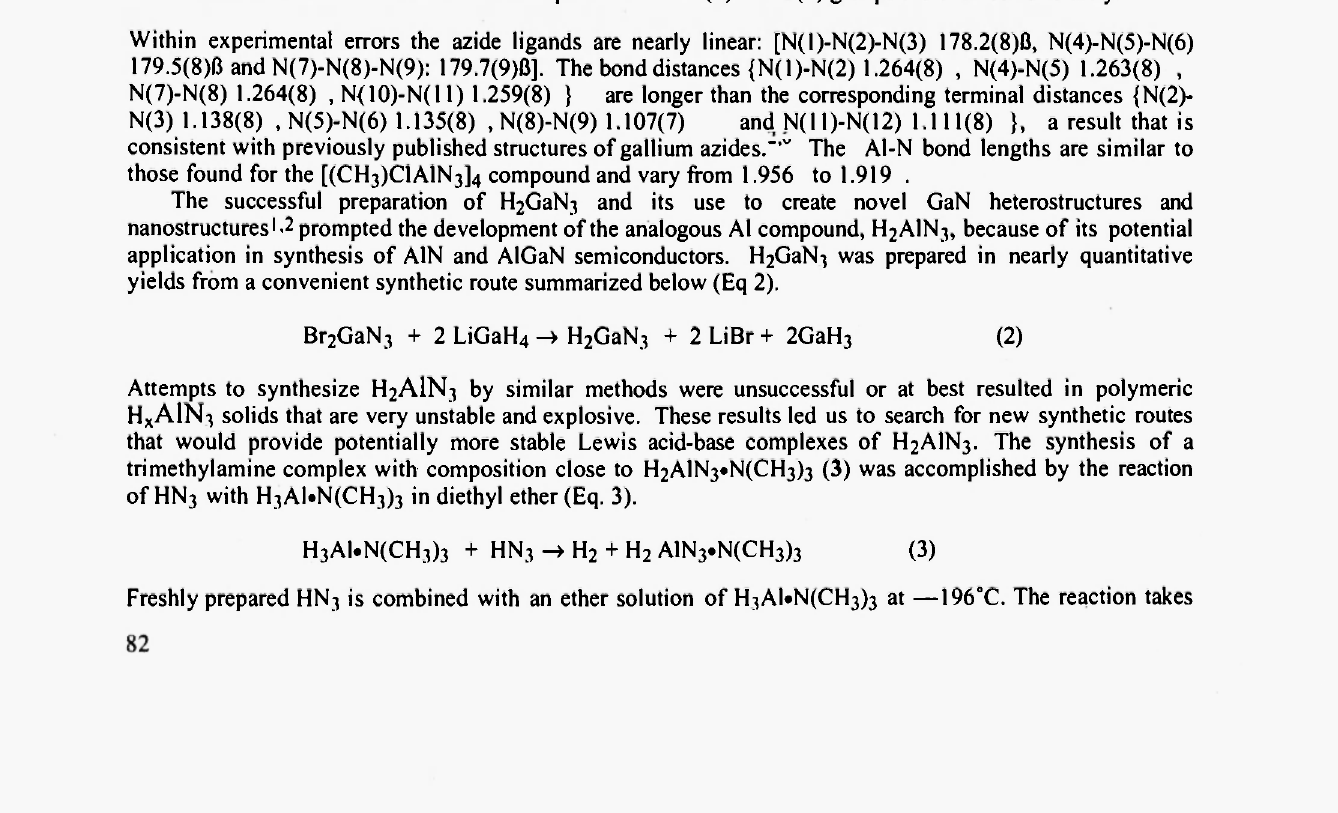
Figure 3. Disordered model of [(ΟΗ 3 )ΒΓΑ1Ν·)] 4 (2). Dotted lines indicate the minor occupancies. The C(l) and C(4) groups are omitted for